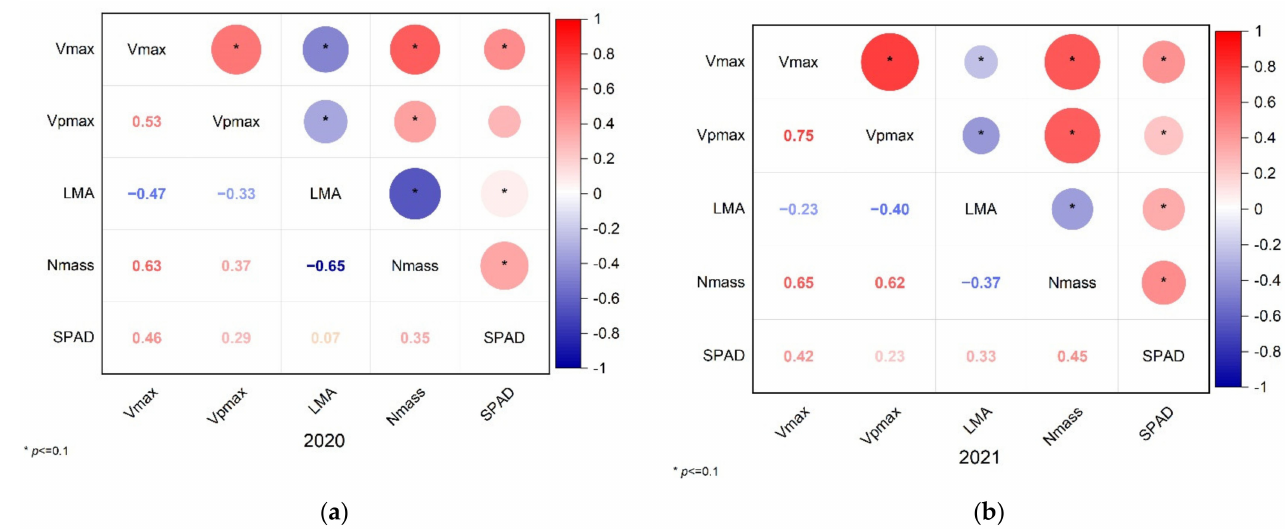
Figure 5. Correlation analysis of leaf biological factors among treatments in 2020 ( a ) and 2021 ( b ). As can be seen from the y-axis on the right, red and blue represent positive and negative correlations, respectively. The numbers are the correlation coefficients.